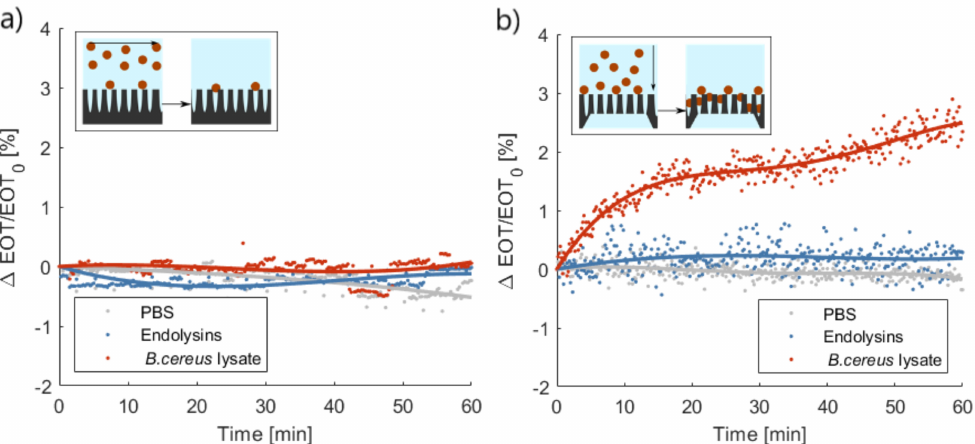
Figure 7. Characteristic relative effective optical thickness (EOT) shift measured on ( a ) a porous silicone (Psi) layer or ( b ) a PSi membrane for 1 h in phosphate buffered saline (PBS), in a PlyB221 endolysin suspension and in a B. cereus lysate ( n ≥ 3). In ( a ), the inset illustrates the flow-over approach; there was no significant shift visible during the detection of either the PlyB221 endolysin or bacterial lysate. In ( b ), the inset illustrates the flow-through approach; there was a significant shift in the relative EOT during the detection of bacterial